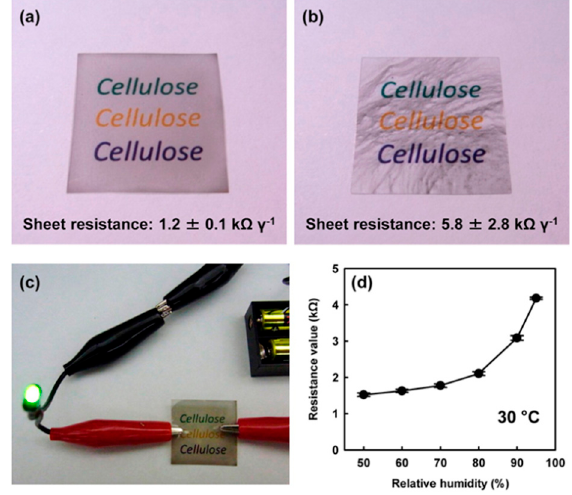
Figure 5. Optical images and sheet resistance measurements at 23 °C and 50% relative humidity (RH) for ( a ) TOCNs–SWNTs ( b ) the CNT cast onto PET films.; these films of 3 × 3 cm were laid on the color-printed word “cellulose” on copy paper. ( c ) The lighting of an LED using a transparent conductive film based on the TOCNs–SWNTs cast PET. ( d ) Correlation between the resistance values of the TOCNs–SWNTs-cast PET film at 30 °C, and the relative humidity. Reproduced with permission from [95]. Copyright American Chemical Society, 2013.